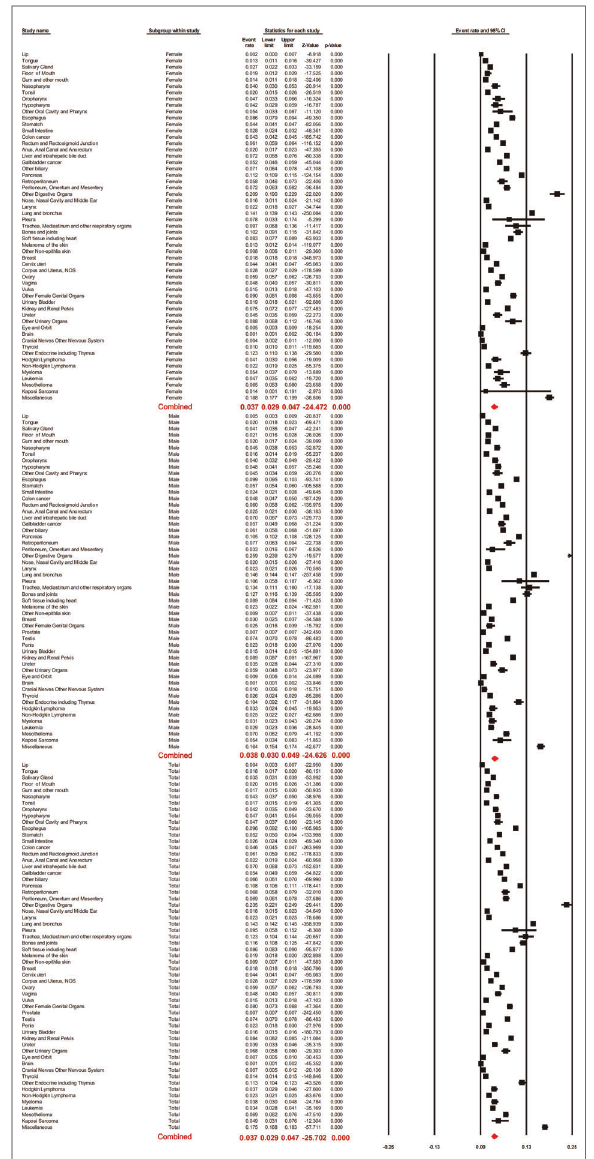
FIGURE 2 Forest plot for the prevalence of lung metastases for different cancer sites, the pooled prevalence of male and female patients, and the total population with random effects